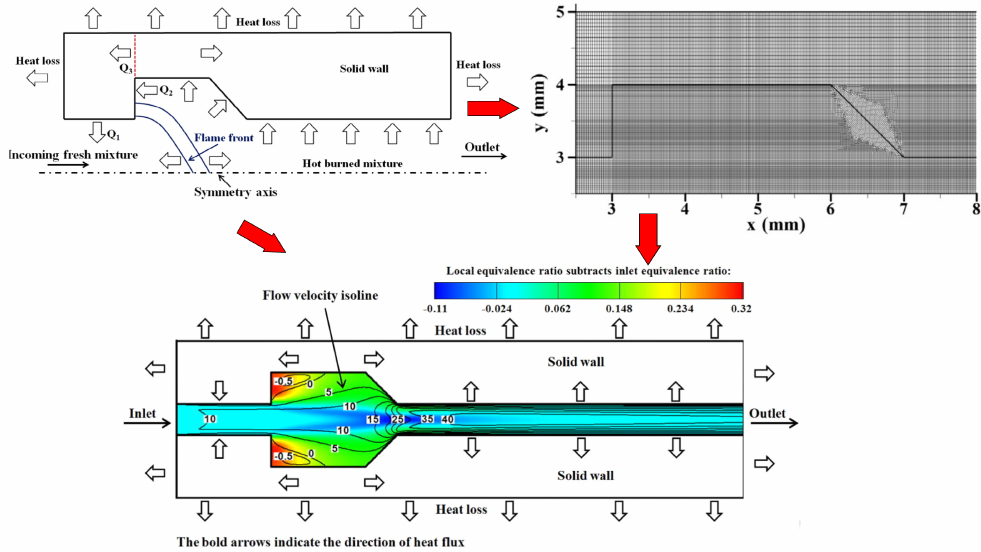
Figure 12. Major flame-anchoring